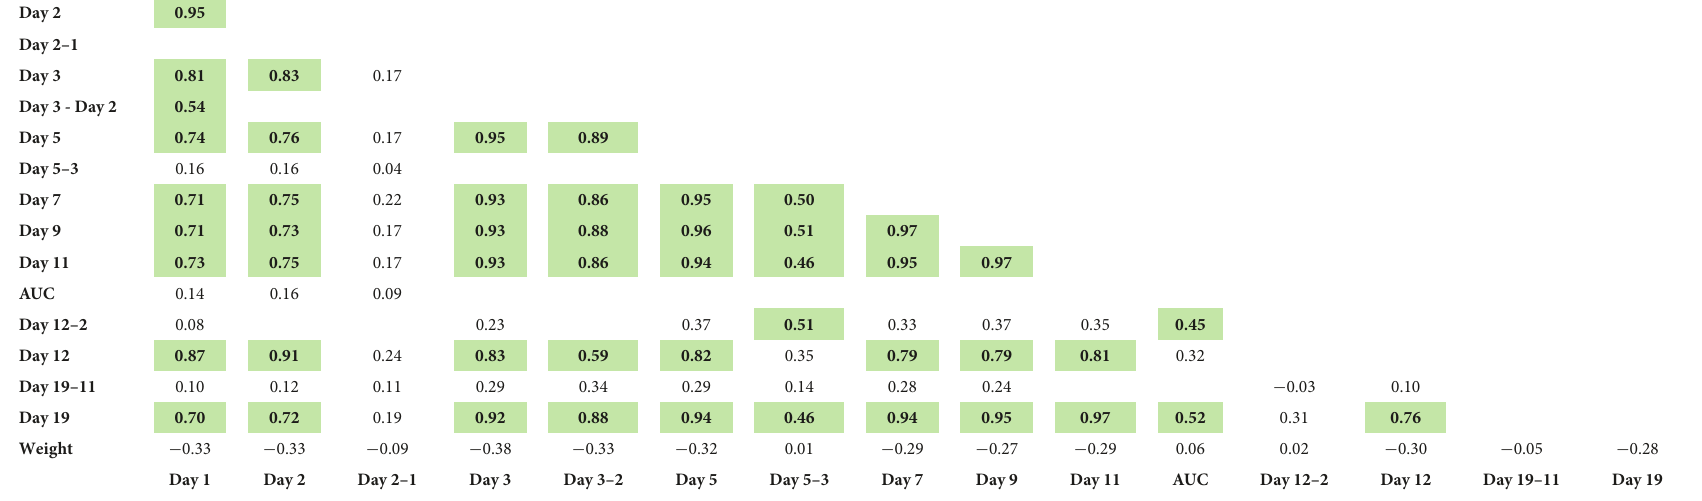
TABLE 3 Pearson correlation coefficients among all measures in CC and founder